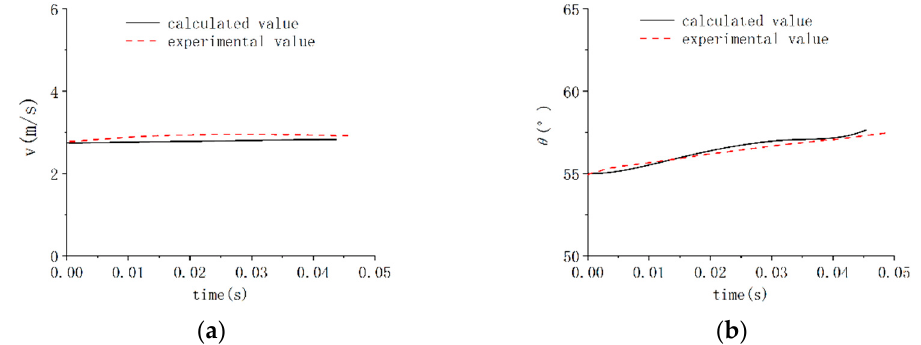
Figure 5. Comparison of the velocity of mass center and inclination angle. ( a ) Velocity of mass center. ( b ) Angle of inclination.